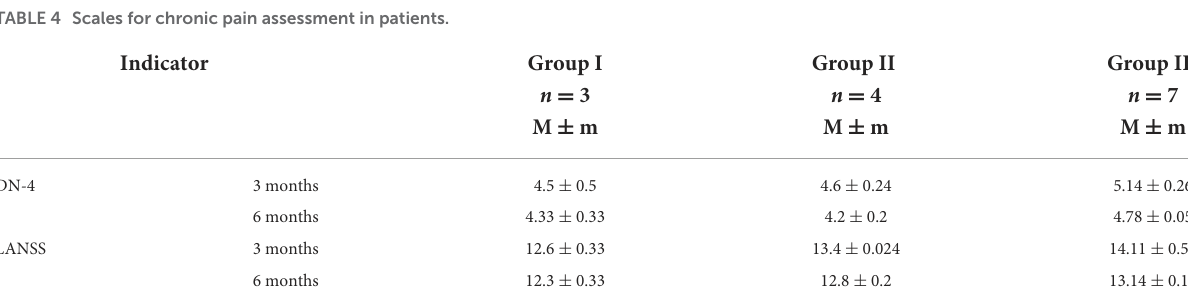
TABLE 4 Scales for chronic pain assessment in patients.